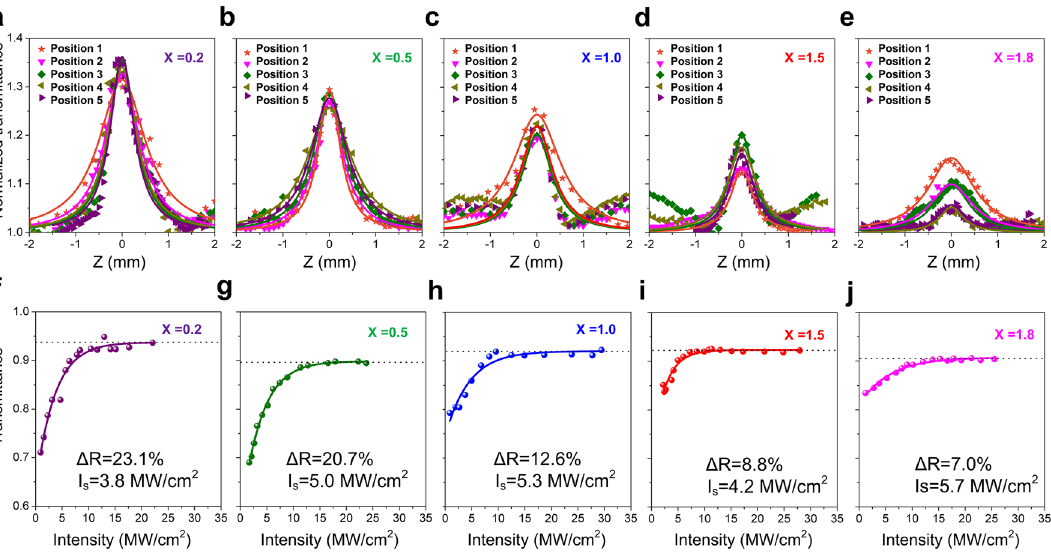
Figure 5: OA Z-scan measured curves of (a) x = 0.2, (b) x = 0.5, (c) x = 1.0, (d) x = 1.5 and (e) x = 1.8; TI-scan measured curves of (f) x = 0.2, (g) x = 0.5, (h) x = 1.0, (i) x = 1.5 and (j) x =